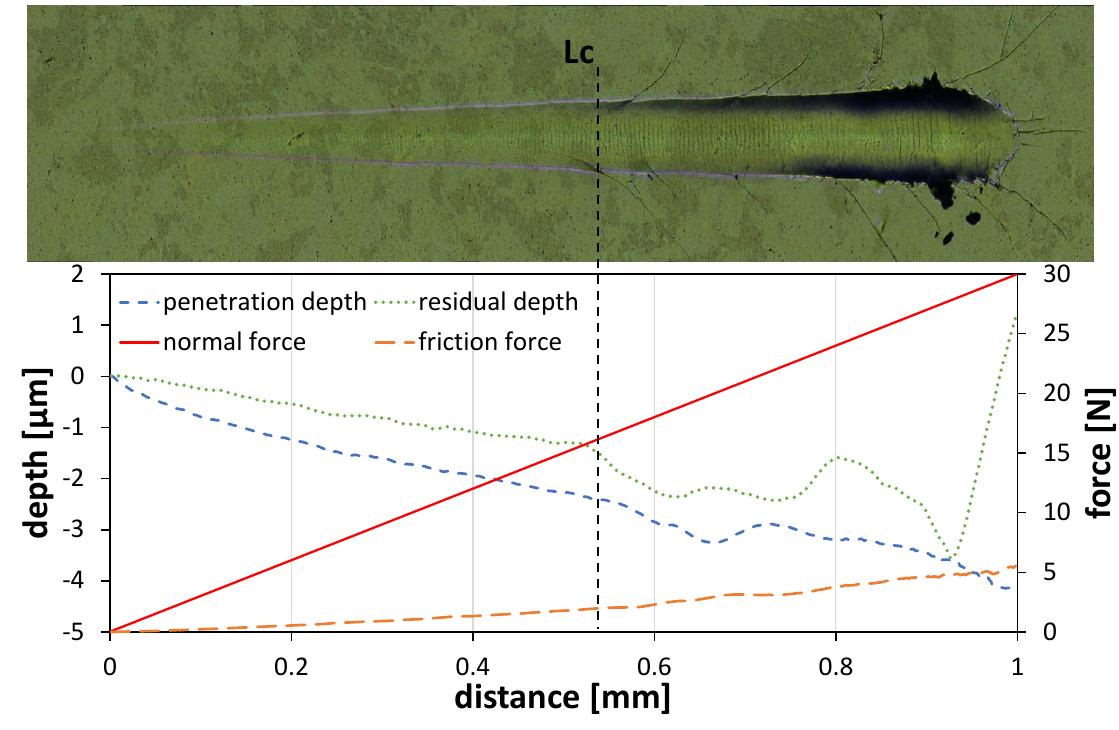
Figure 5. Scratch panorama and measured signals on FeAl_Si